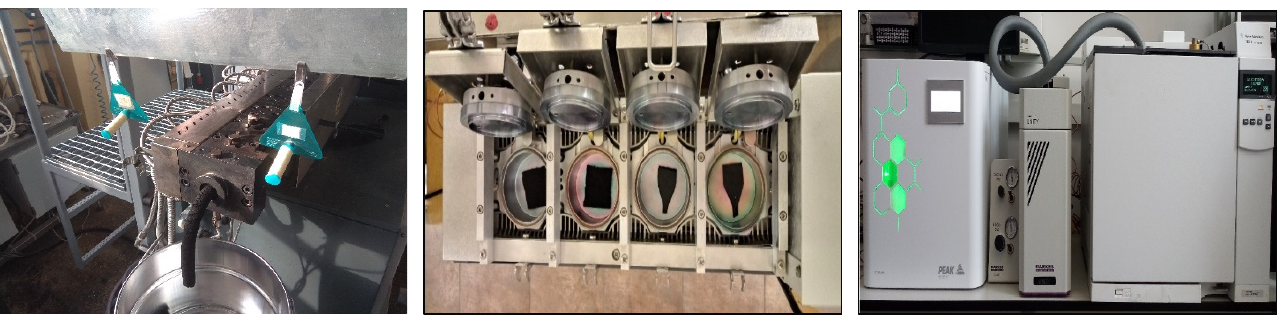
Figure 5. The appearance of the apparatus for determining the TVOCs parameter; from left: Radiello ® passive sampling system; Micro-Chamber/Thermal Extractor TM ; gas chromatograph.